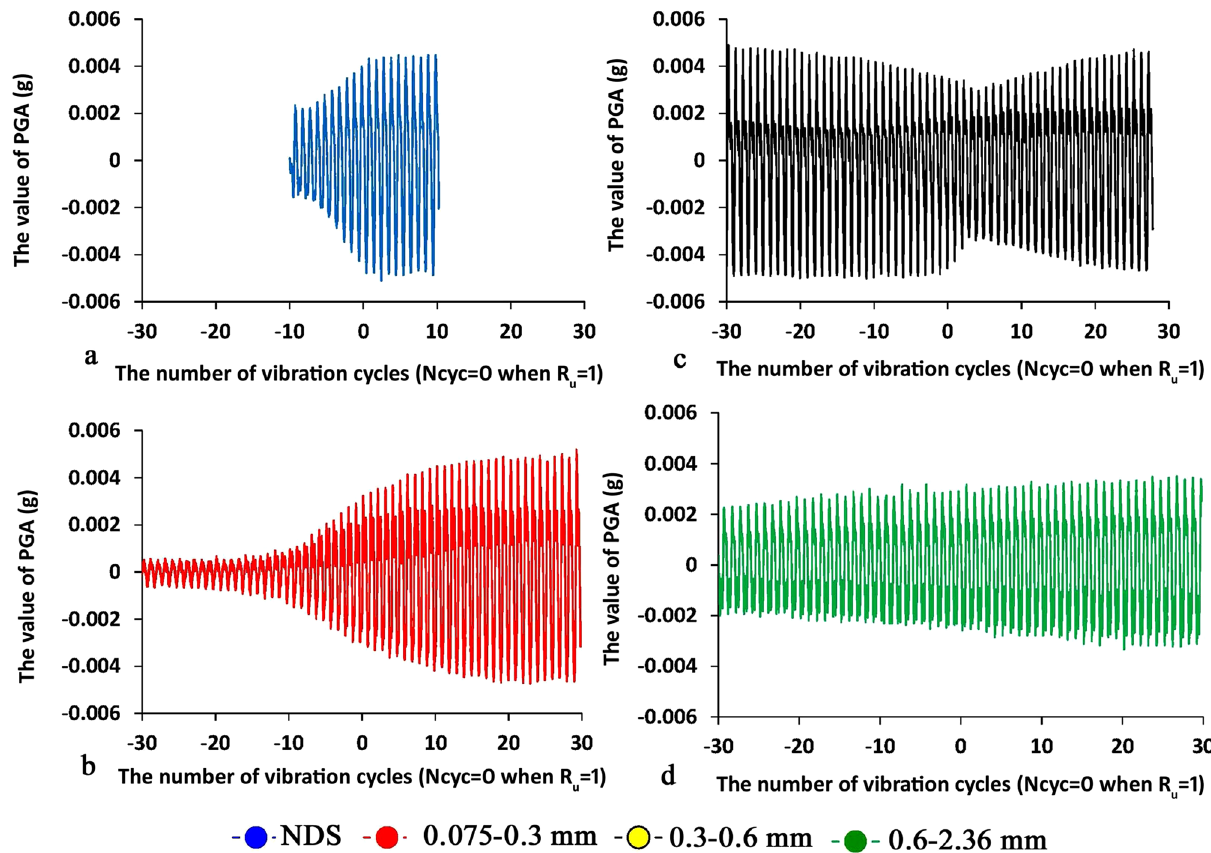
Figure 11. The changes of the value of PGA (g) vs. the number of vibration cycles N cyc for four sand samples under study, the X-values is the number of vibration cycles while 0 when the R u is reached to 1—Fig. 4 (the negative value of N cyc means the state before the liquefaction point while the positive values after the liquefaction point), the PGA values in g units. The blue, green, black, and red lines are for natural dune sand,